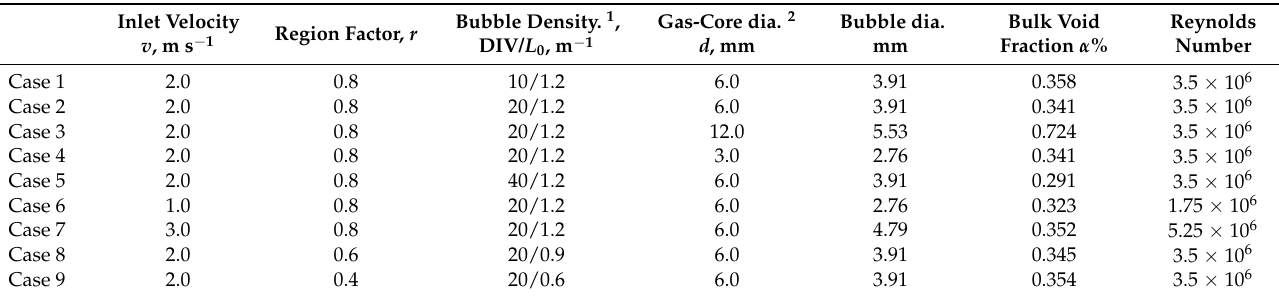
Table 1. Calculating cases under different simulation